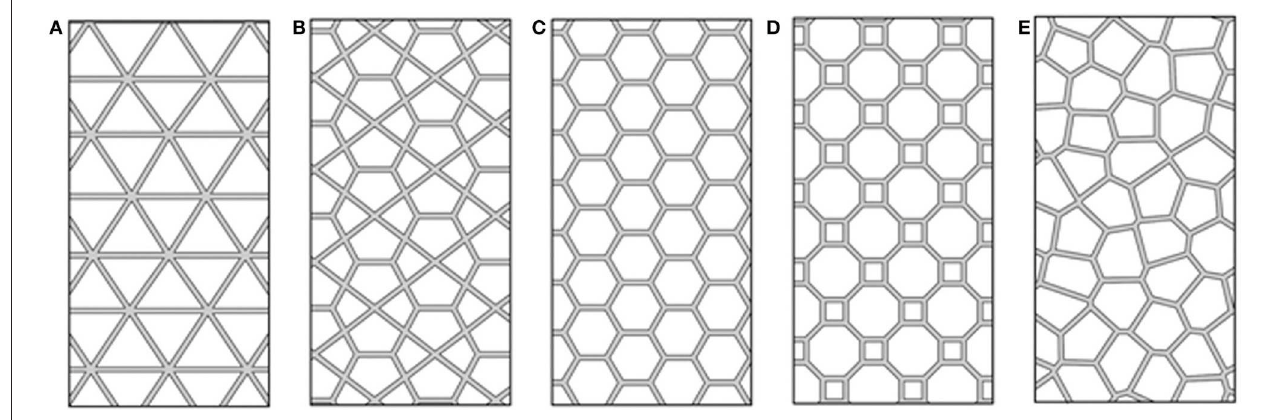
FIGURE 1 | Grid examples: (A) Diagrid, (B) Pentagrid, (C) Hexagrid, (D) Octagrid, and (E) Voronoi